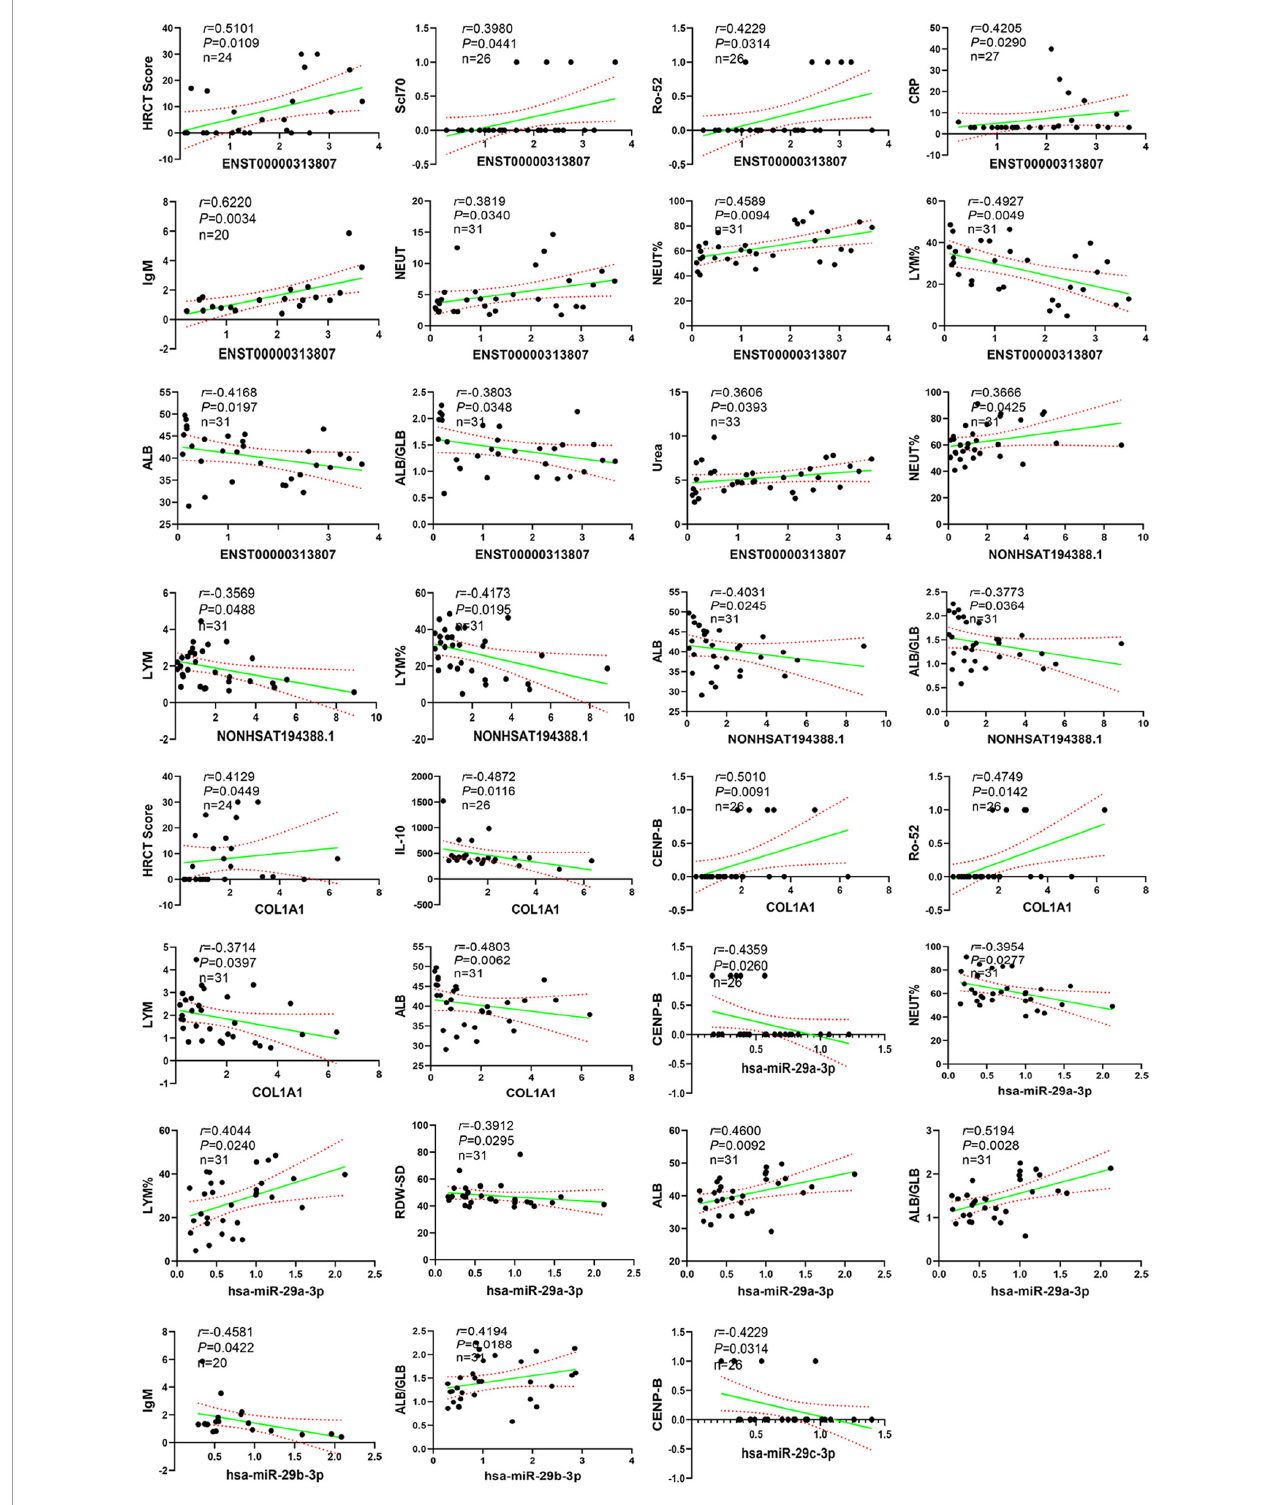
FIGURE12 Correlation analysis between RNA expression and clinical data. The solid green line is a regression straight line, which is used to describe the relationship curve between the dependent variable y and the independent variable x with a linear relationship. The area formed by the red dotted line represents the 95% confidence interval. NEUT, neutrophil; NEUT%, neutrophil percentage; LYM, lymphocytes; LYM%, lymphocytes percentage; ALB, albumin; ALB/GLB, albumin divided by globulin; RDW-SD, red cell distribution width-standard deviation; HRCT, high-resolution CT; CRP, C-reactive